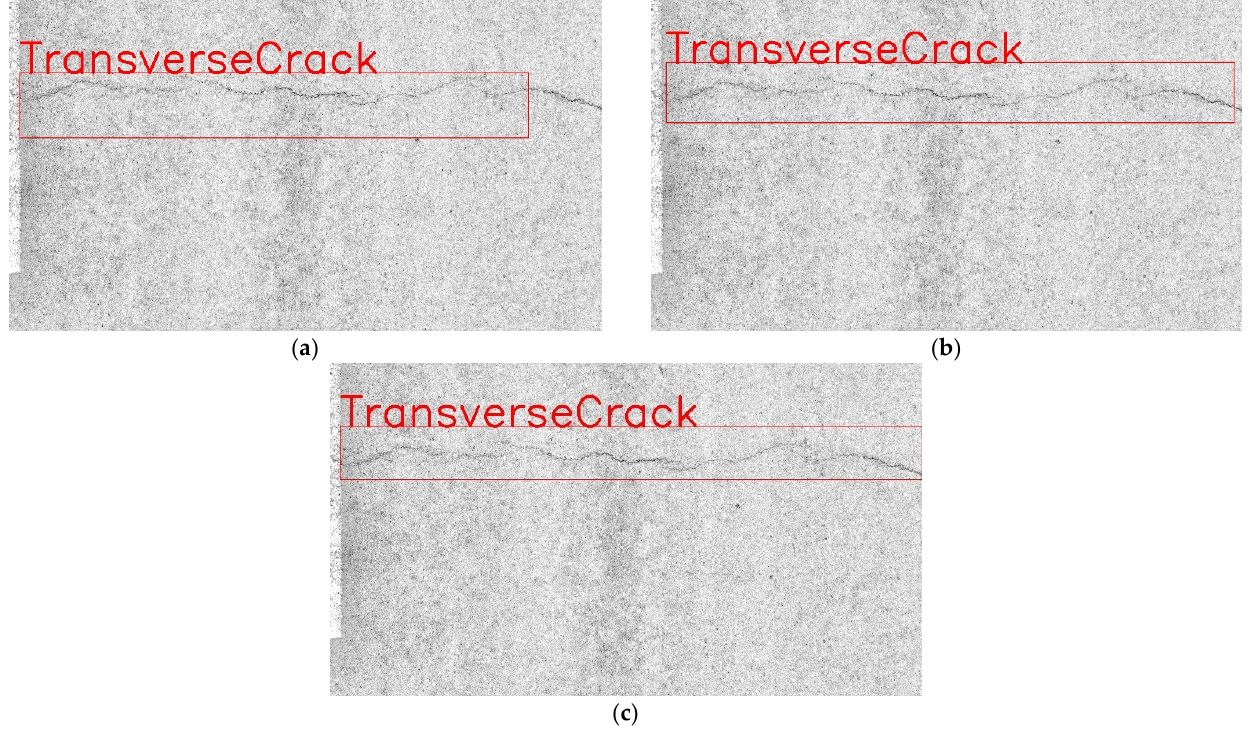
Figure 17. Detection results under different networks. ( a ) Baseline. ( b ) Baseline + SimAM. ( c ) Baseline + SimAM + Transformer.